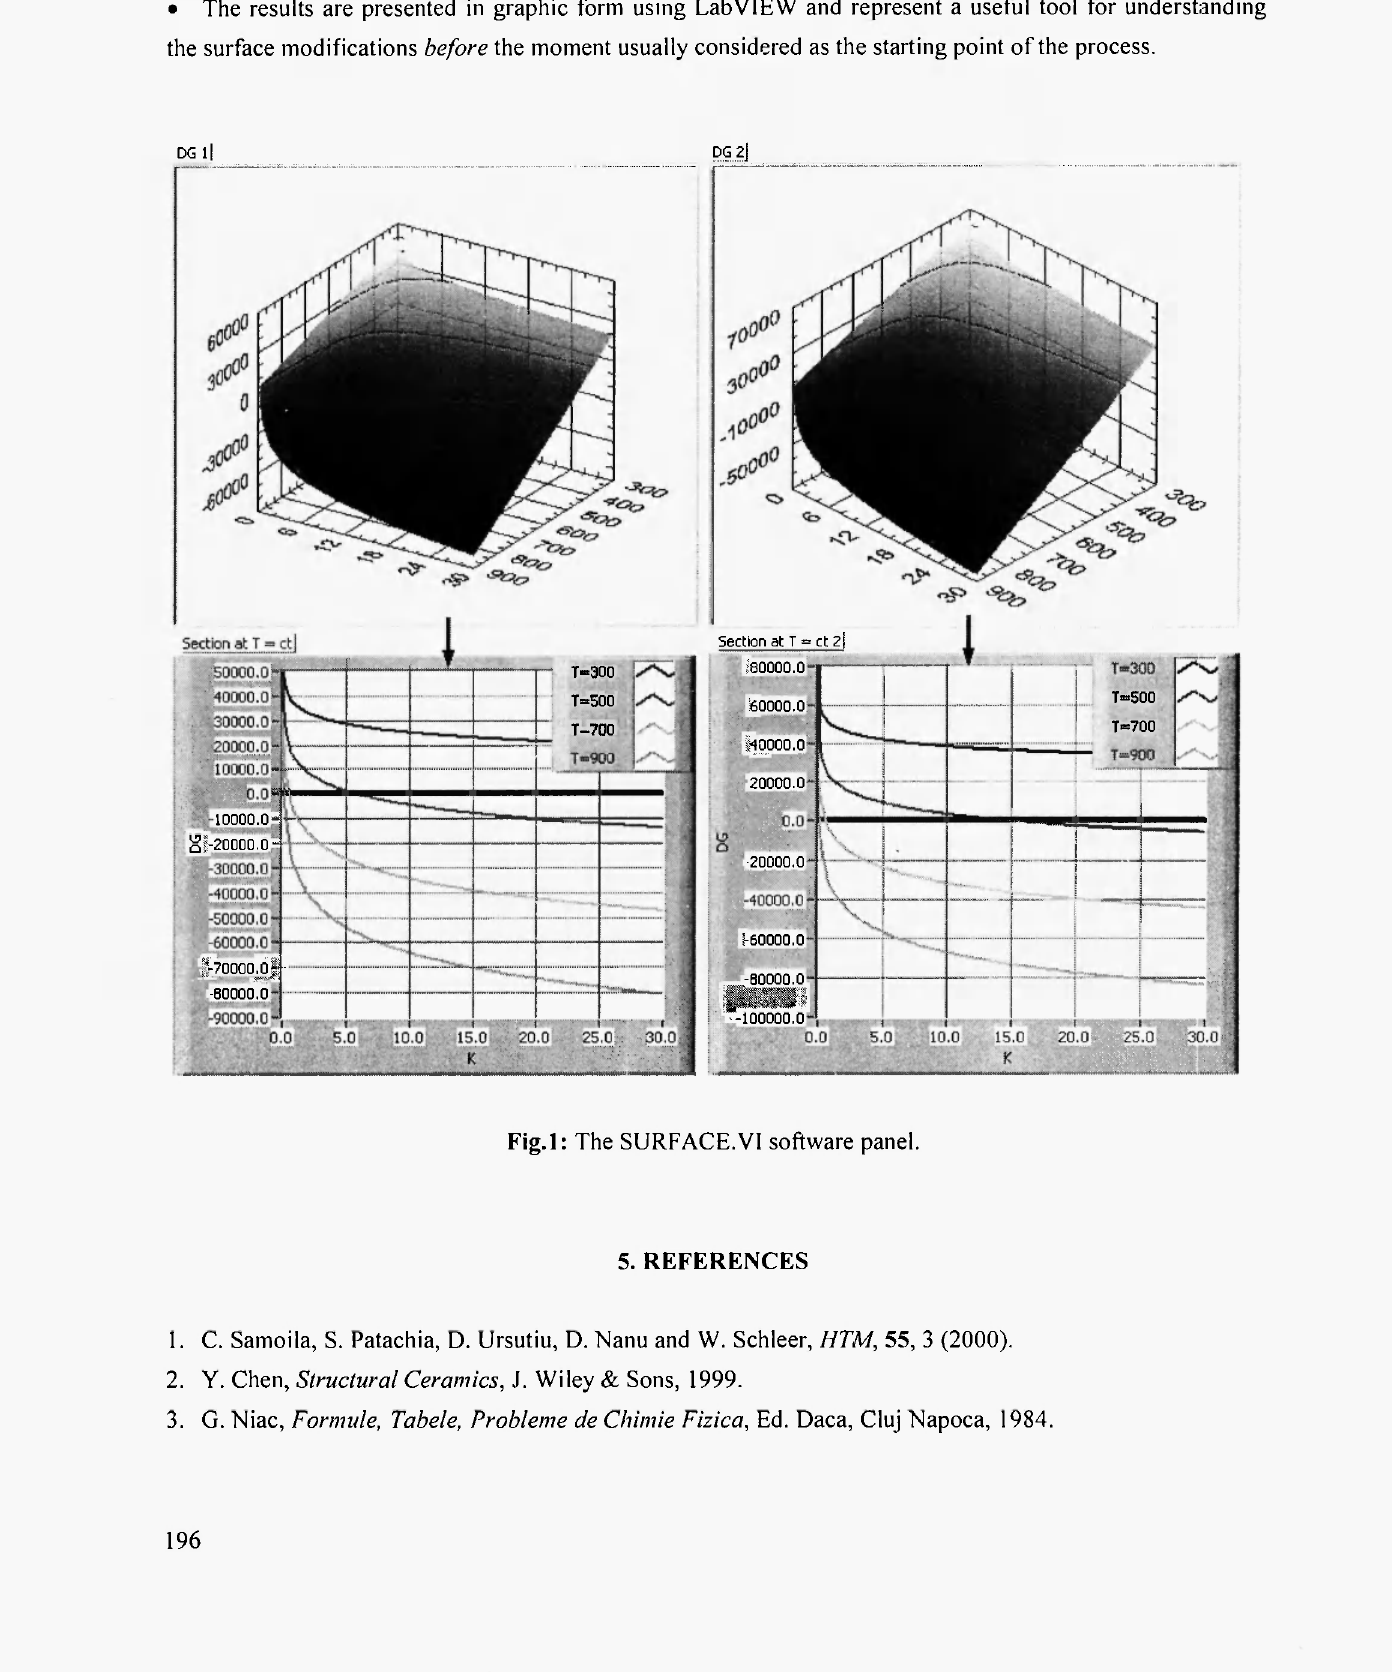
Fig.l: The SURFACE. VI software